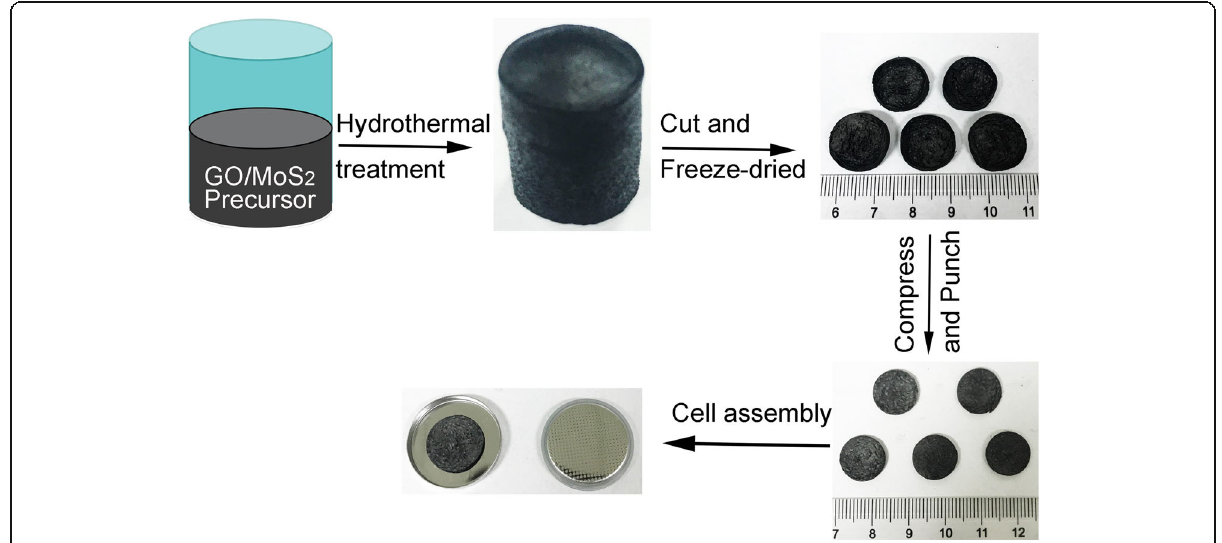
Fig. 1 Schematic of fabrication of hybrid nanostructure of MoS2/RGO